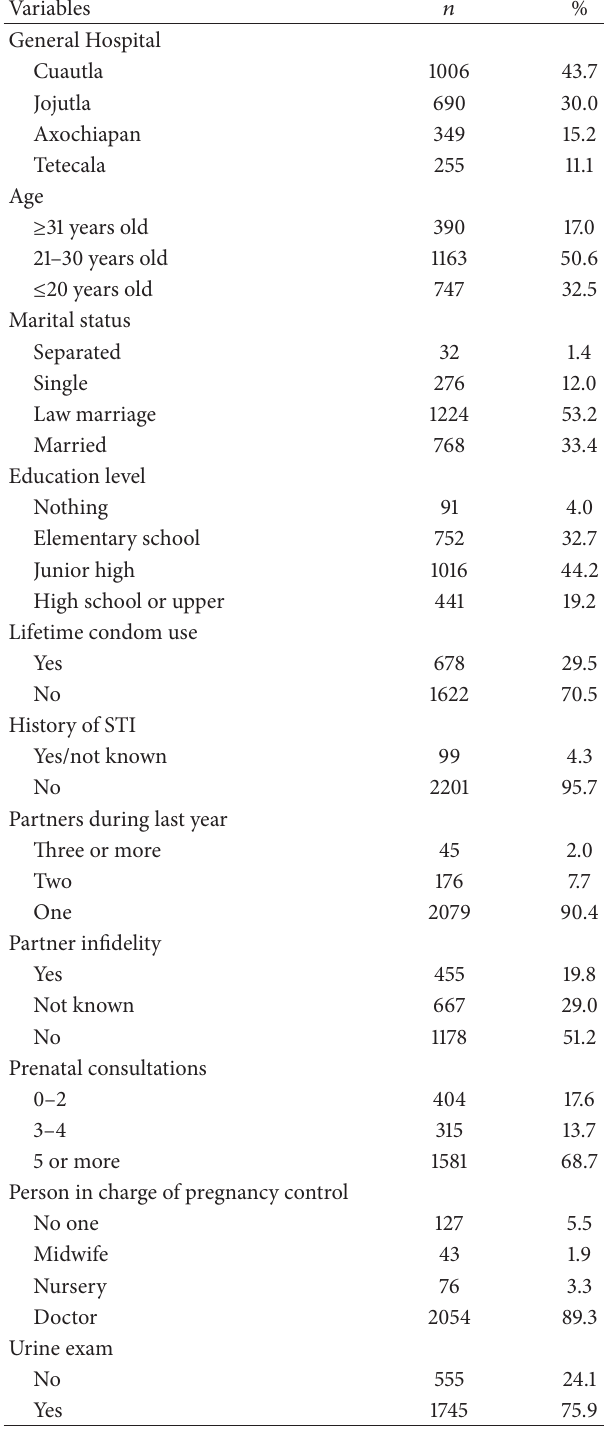
Table 1: Demographic, sexual behaviors, and antenatal care charac- teristics of puerperal and pregnant women from Morelos,